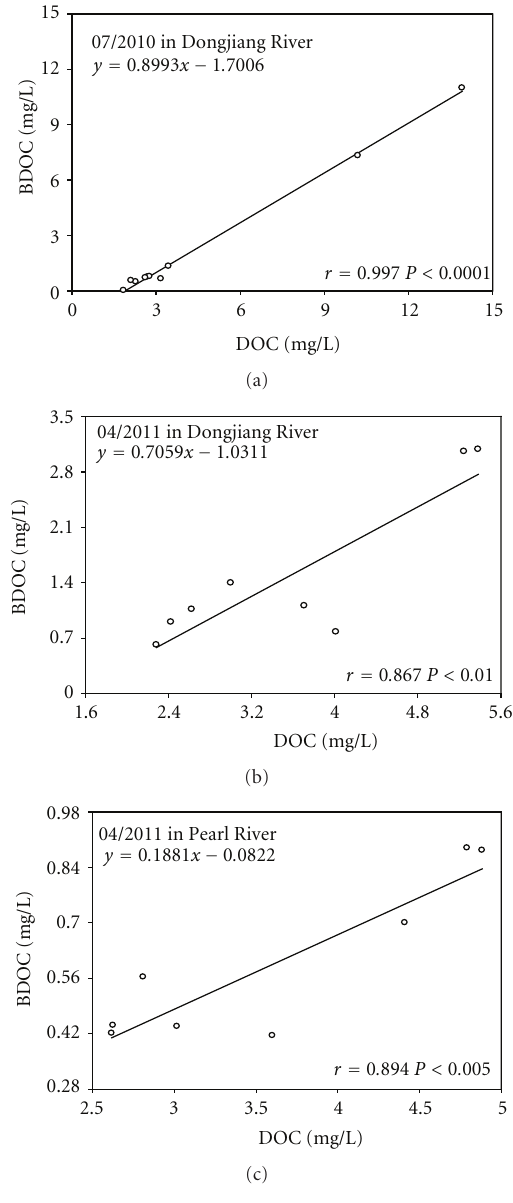
Figure 2: Correlations of DOC with BDOC of PAHs in Pearl River